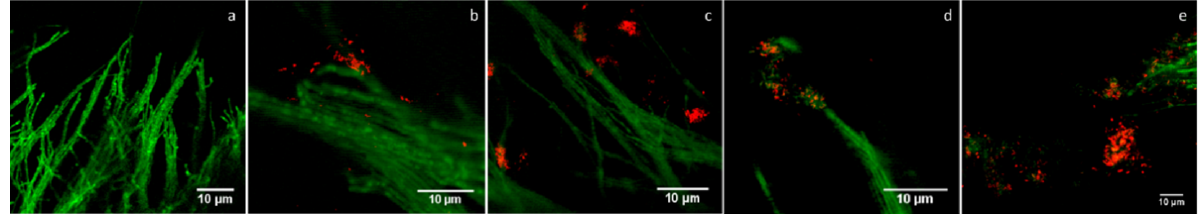
Figure 8. Imaging of microcolonies of S. indica co-cultured with C. fungivorans for 72 h at 24 °C. The colonization of the fungal hyphae by C. fungivorans was observed microscopically. ( a ) S. indica hyphae without bacteria (control). ( b ) C. fungivorans attached to the hyphal tips and forming bacterial aggregates 4 h post inoculation. ( c ) Lysis of hyphal tips was observed after 24 h. ( d , e ) After 72 h, broken hyphae of S. indica were observed. The GFP-and RFP-expressing strains of S. indica and C. fungivorans were used and images were taken using a confocal microscope at 40× magnification.